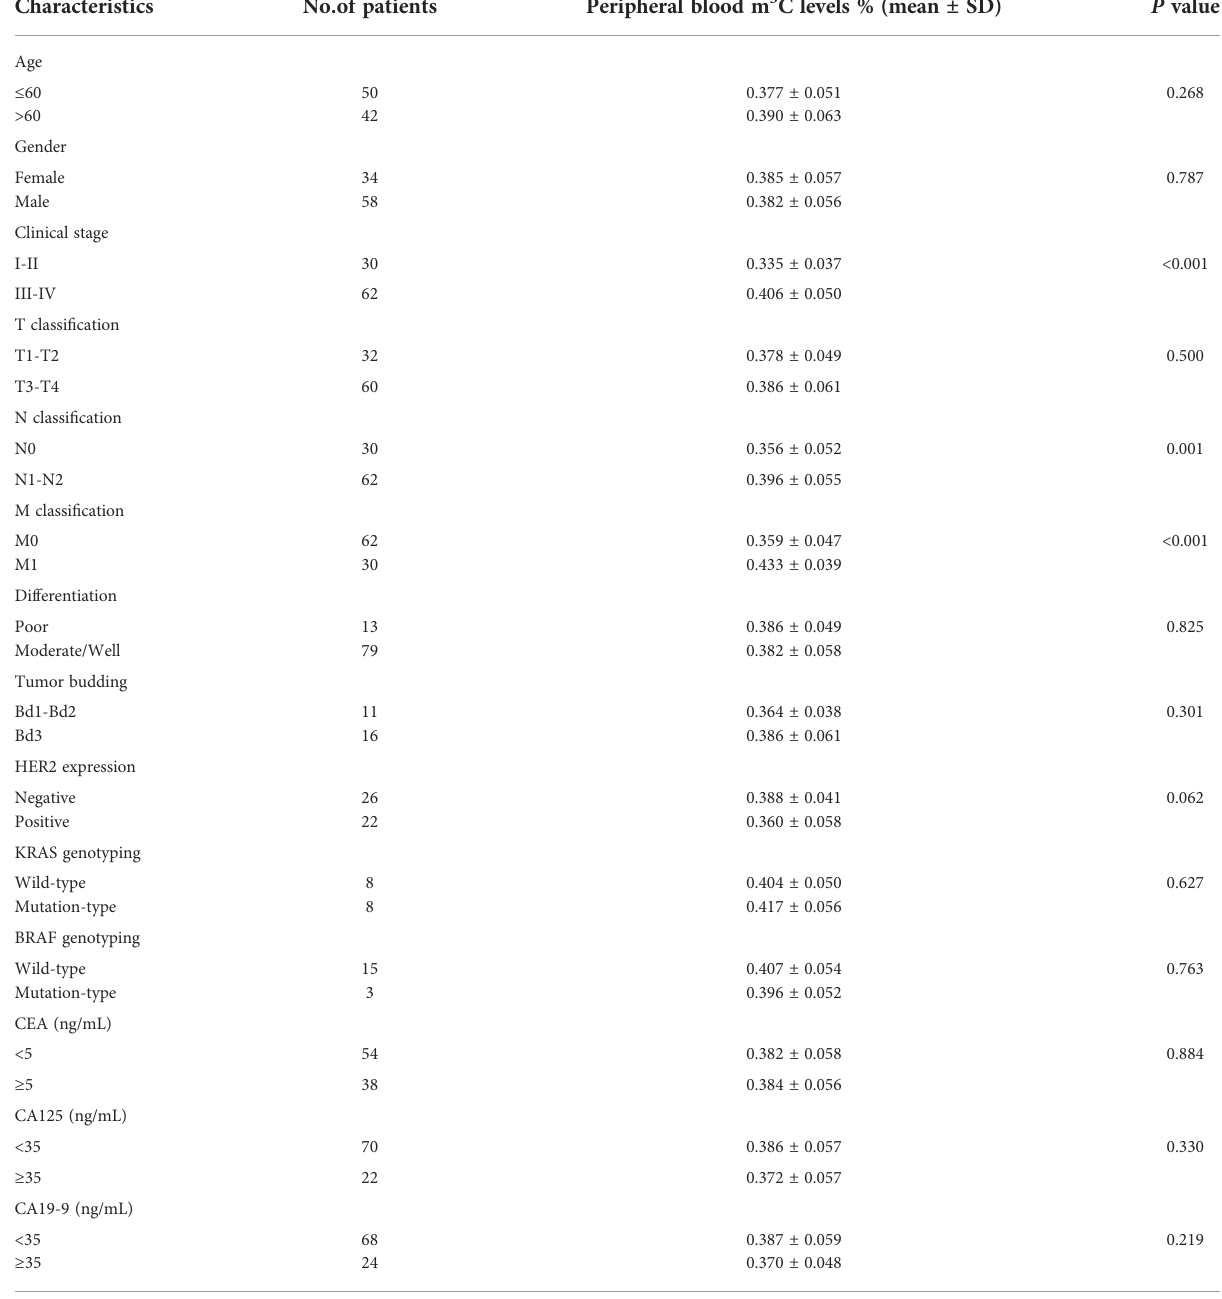
TABLE 1 Correlation between the levels of m 5 C and clinicopathological characteristics in the training set.